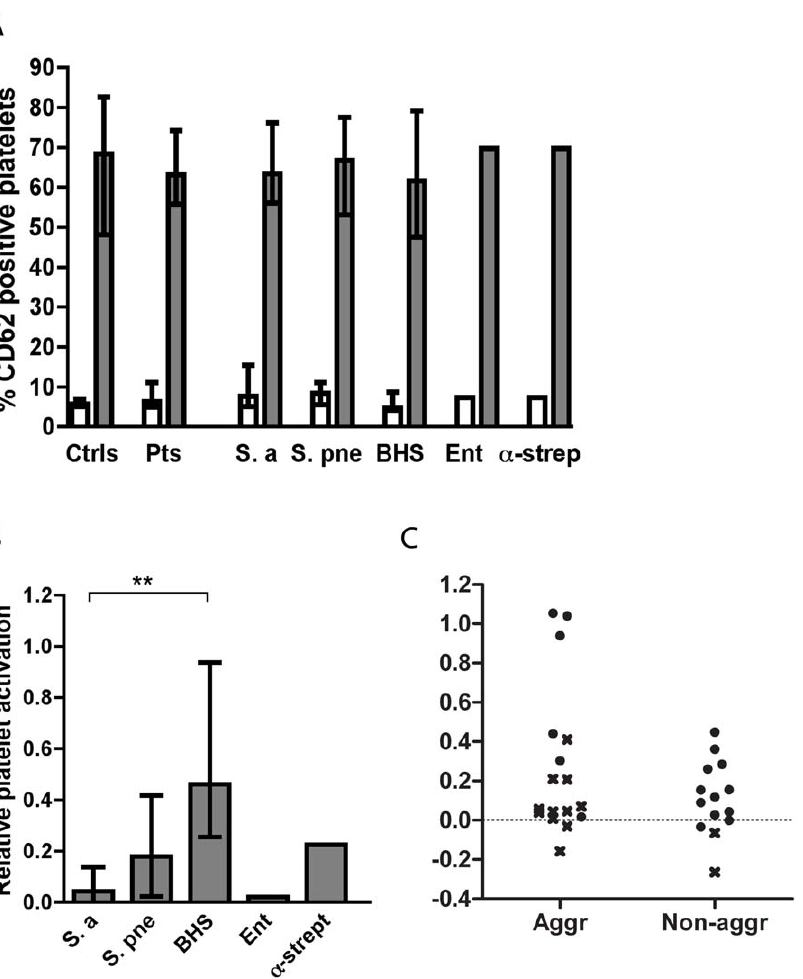
Figure 2. Platelet activation in healthy controls and in patients. (A) Platelet activation in healthy controls (ctrls), in all patients (pts), and in patients grouped by their respective infective organism. Platelet activation is shown as the percentage of CD 62-positive platelets in response to buffer only (open bars) or to ADP (grey bars). In (B) the increase in activated platelets in response to different bacterial isolates compared to buffer relative to the increase caused by stimulation by ADP compared to buffer is shown. Values are expressed as medians 6 interquartile range. * P , 0.05 after Mann-Whitney U testing. In (C) the percentage of CD 62-positive platelets in response to bacteria in patient blood is shown in two groups. To the left, patients responding with platelet aggregation to the bacterium are shown and to the right patients not responding with aggregation to the bacterium are depicted. Crosses represent S. aureus , while filled circles represent other bacteria. The difference between the groups is significant only if the results obtained with the S. aureus isolates are excluded.